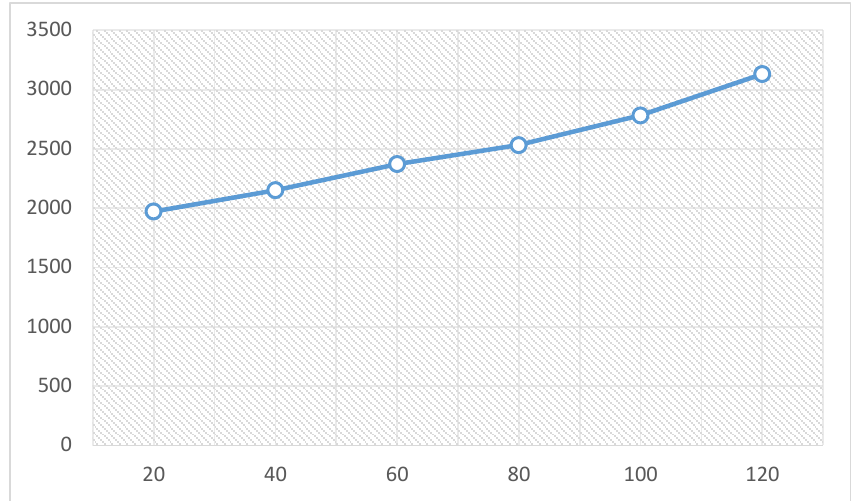
Figure 11. OFV3 vs. cost of performing each